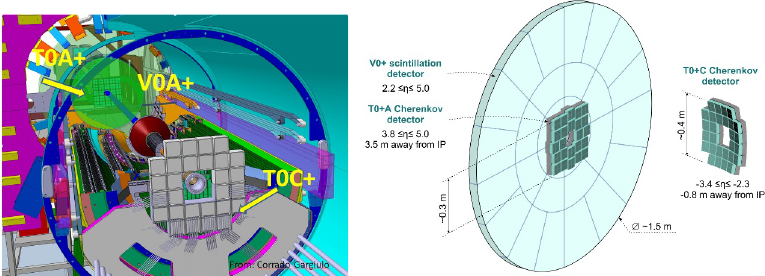
Figure 2. Left: View of FIT detector integrated in ALICE. Right: Active components of the FIT detector; the size and pseudorapidity coverage are indicated on the drawing